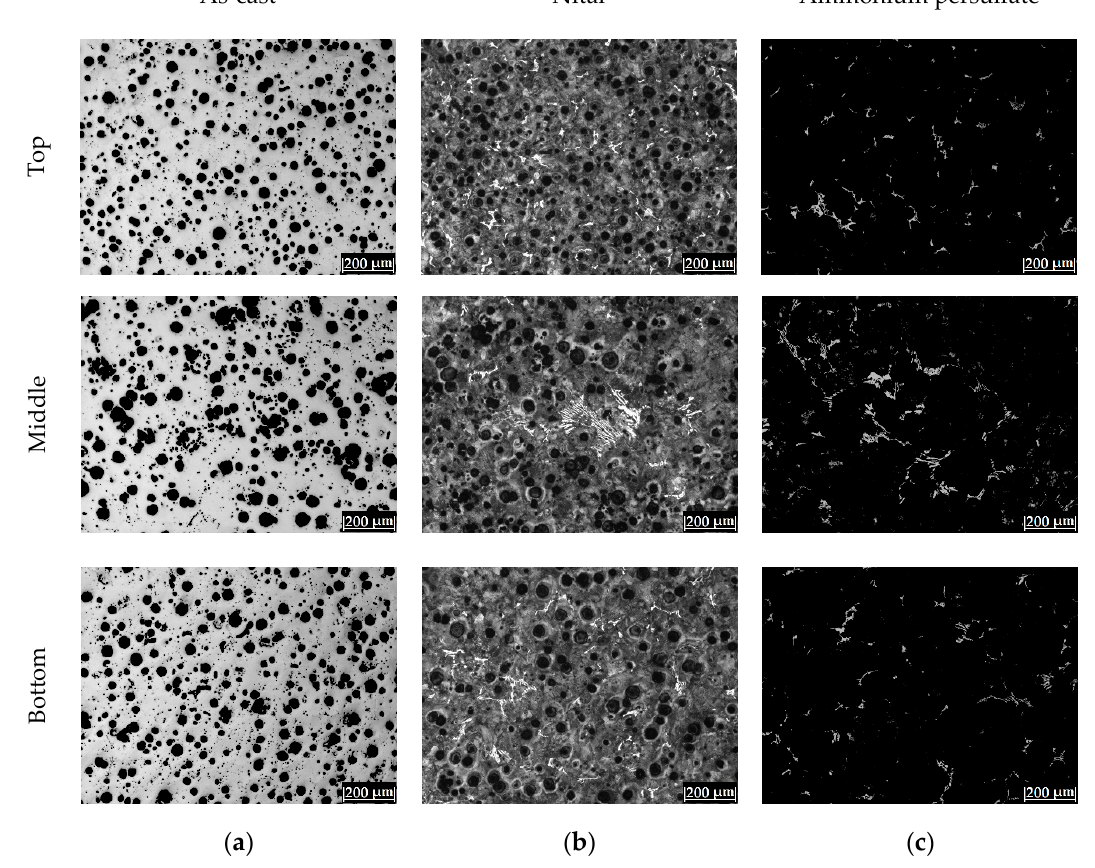
Figure 5. Microstructure of DI-0.4Cr sample for the top, middle, and bottom zones for ( a ) as-cast, ( b ) etched with nital, and ( c ) etched with ammonium persulfate conditions.